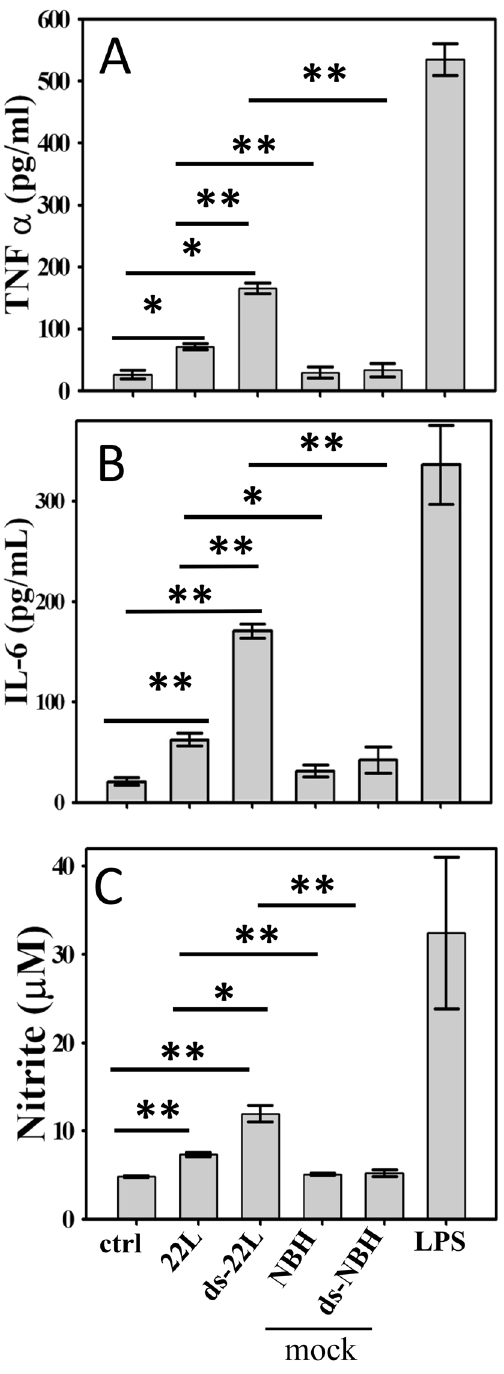
Figure 2. Analysis of PrP Sc -induced proinflammatory responses in BV2 cells. Levels of TNF α ( A ) IL6 ( B ) and NO ( C ) measured upon incubation of BV2 cells with purified 22L or ds-22L PrP Sc for 18 hours. As negative controls, cells were treated with mock-purified NBH or ds-NBH, or cultured in the absence of treatment (ctrl). As a positive control, cells were treated with LPS (100 ng/ml). The final concentrations of 22L or ds-22L PrP Sc in the cell culture media were equivalent to the amounts of PrP Sc in 0.75% 22L scrapie brain homogenate. All experiments were performed three times, and the data are presented as the mean ± SD. Statistical significance (P) were calculated by Student’s t-test and indicated as * and ** for P < 0.05 and P < 0.005,